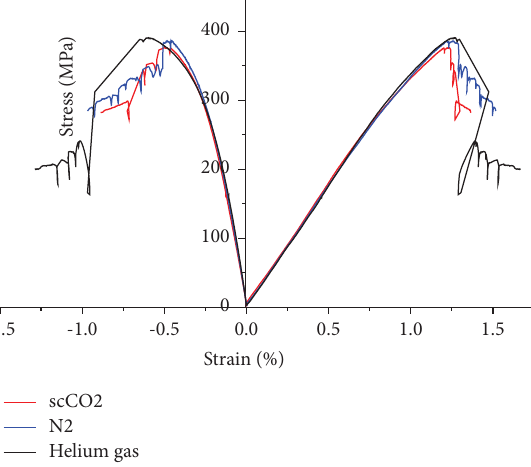
Figure 5: Stress-strain curves at the coring angle of 0 ° (positive and negative values of strain represent axial and radial strains, re- spectively, the same in the other stress-strain plots).